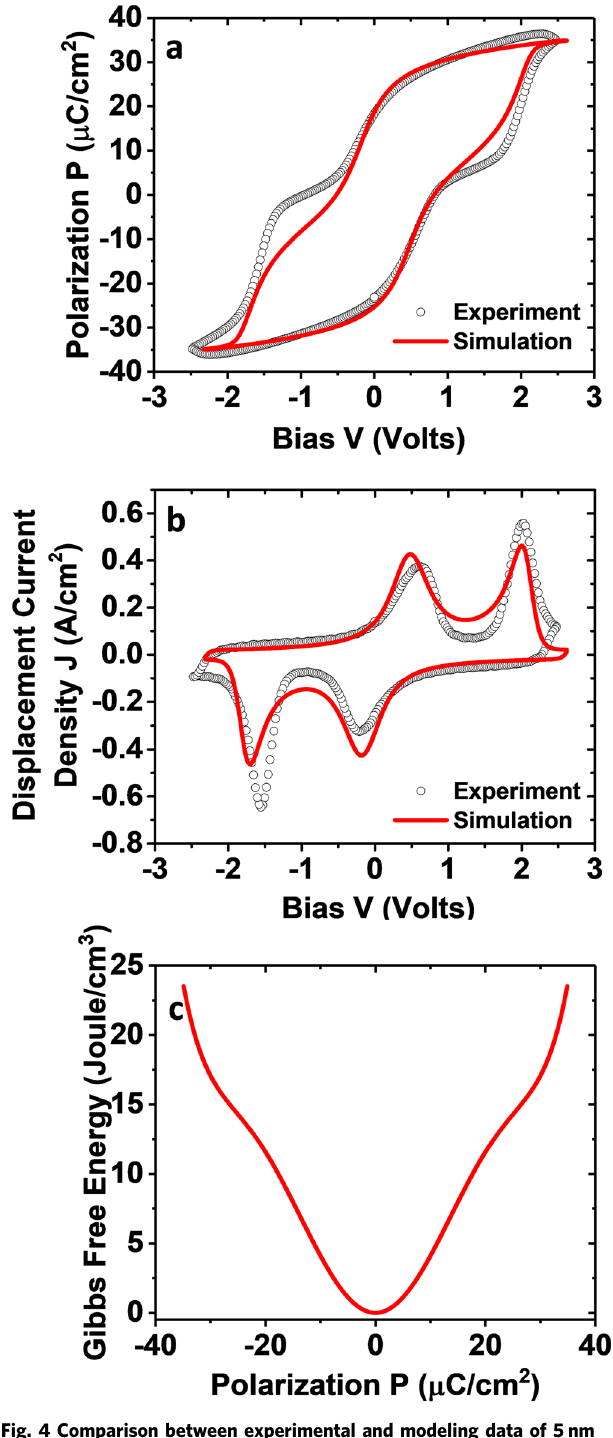
Fig. 4 Comparison between experimental and modeling data of 5 nm Hf 0.5 Zr 0.5 O 2 thin fi lm. a , b Experimental data (dotted) and simulation (red line) of Polarization ( P ) and Displacement current ( I ) respectively, as a function of Voltage ( V ) at 1KHz for 5 nm Hf 0.5 Zr 0.5 O 2 (HZO) fi lms. c Gibbs free energy landscape drawn using the Landau coef fi cients which